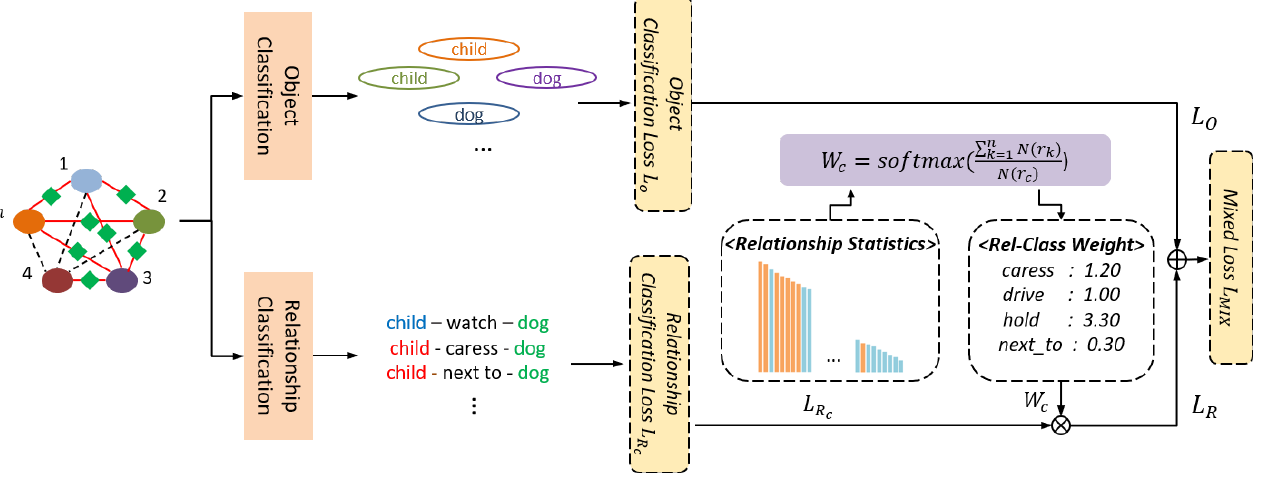
Figure 5. Object and relationship classification (ORC).